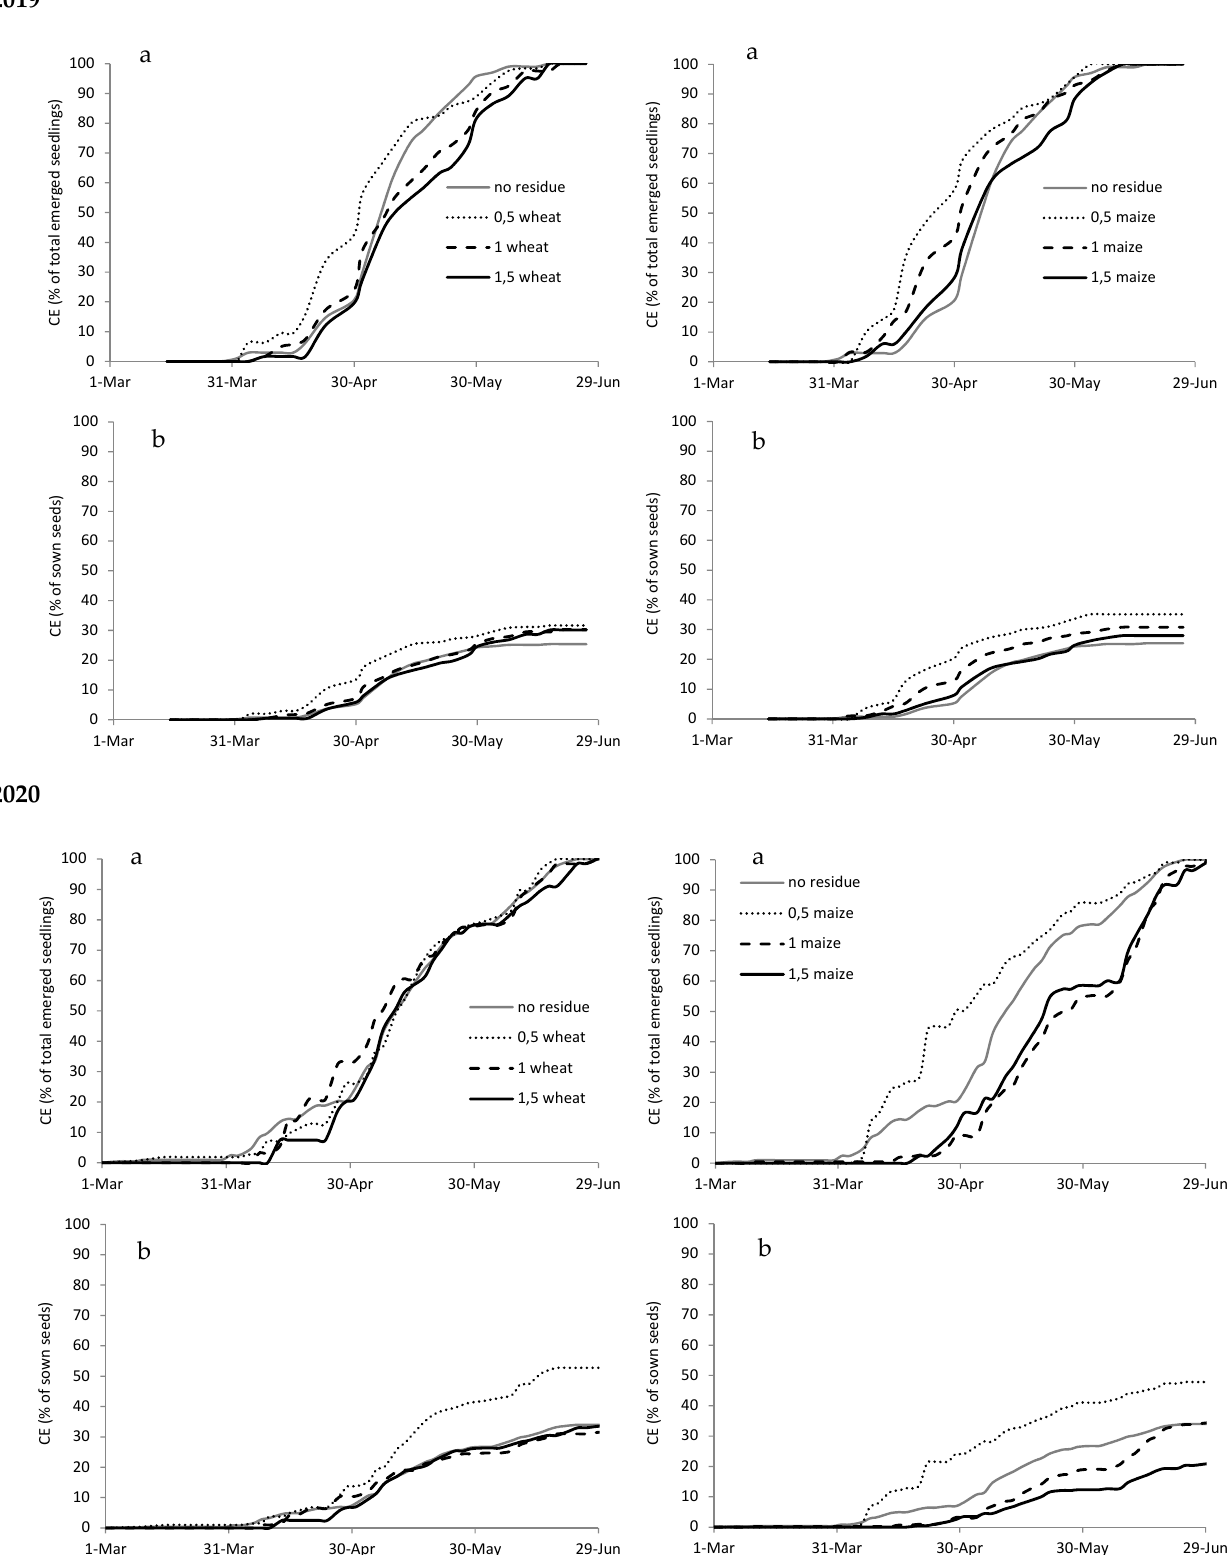
Figure A8. Cumulated emergence (CE) expressed as percentage of total emerged seedlings ( a ) and as percentage of sown seeds ( b ) of Sorghum halepense in 2019 and 2020 with different types (wheat on the left and maize on the right) and amounts of crop